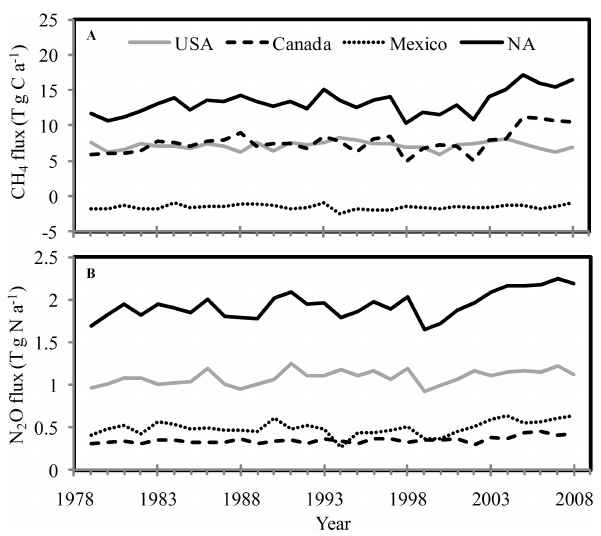
Fig. 6. CH 4 and N 2 O fluxes in North America’s terrestrial ecosys- tems by countries during